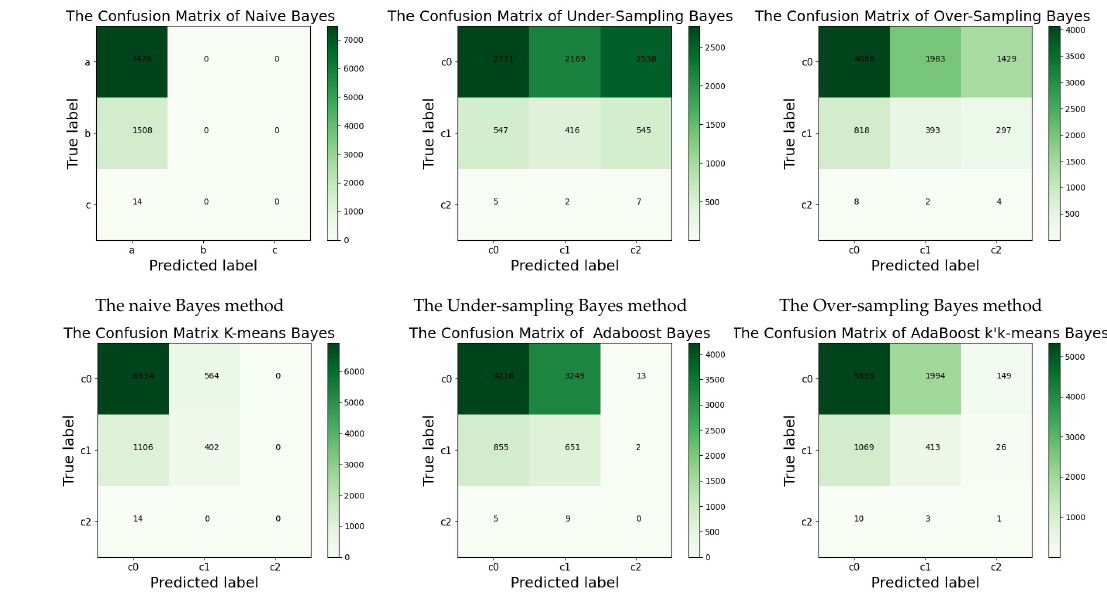
Figure 1. The confusion matrices of the six methods.